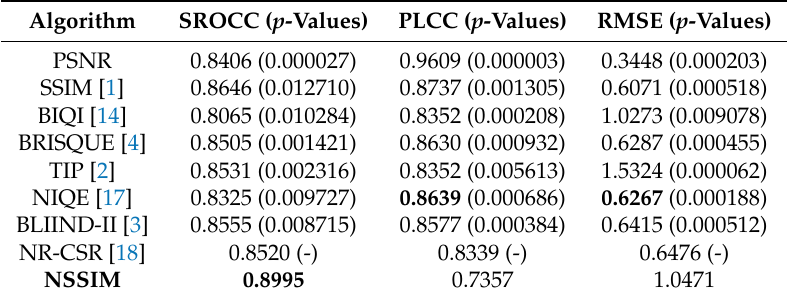
Table 9. Comparison with eight existing IQA algorithms on TID2013 dataset (125 Gaussian blur images). We take Spearman’s rank order correlation coefficient (SROCC), Pearson linear correlation coefficient (PLCC) and root mean square error (RMSE) as evaluation indexes. In each column, the best performance value is marked in